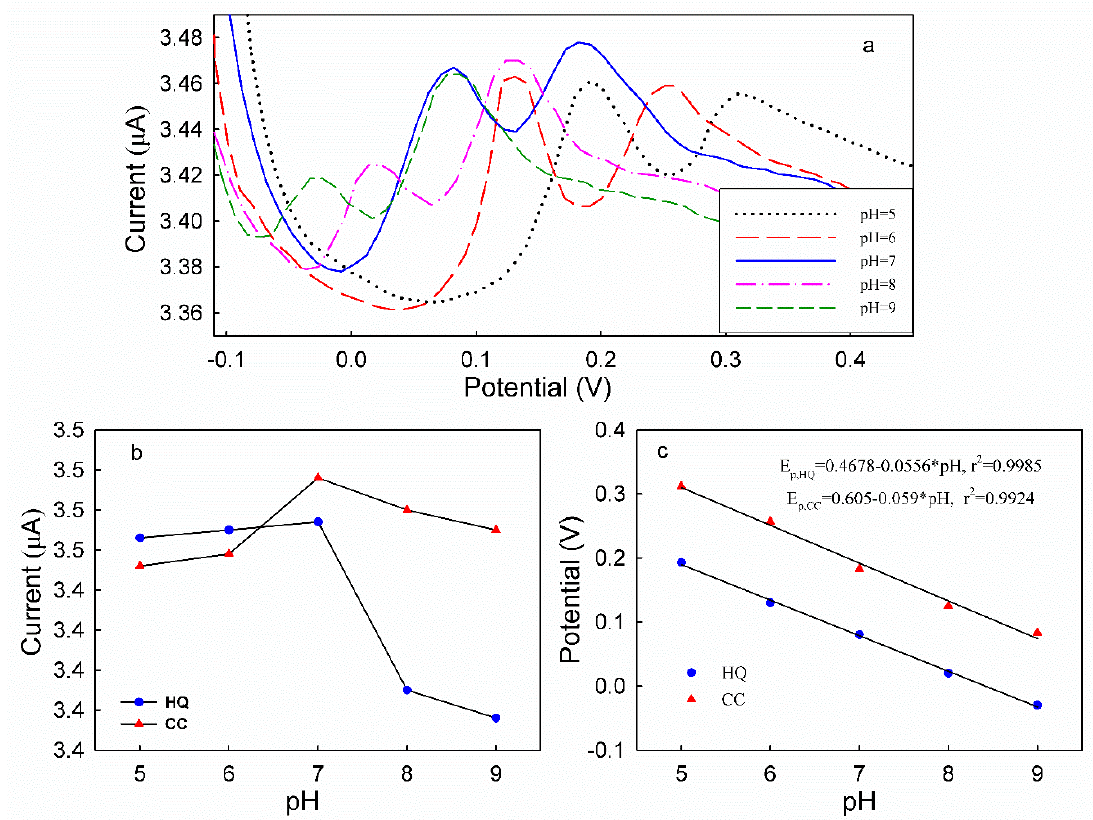
Figure 10. ( a ) DPV results of 0.1 mmol/L HQ and 0.05 mmol/L CC on the PGDIL–TiO 2 /Au electrode under different pHs at a scan rate of 0.1 V/s. ( b ) The relationship between I p and pH. ( c ) The relationship between E p and pH.